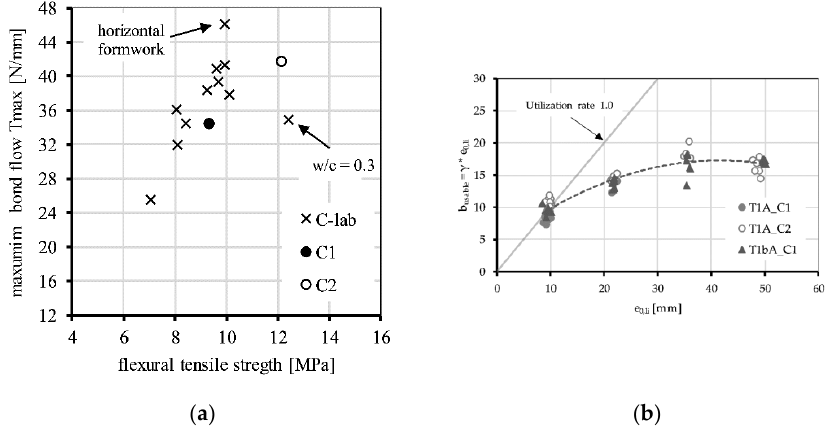
Figure 4. ( a ) The correlation between the flexural tensile strength of fine-grained concrete on the maximum bond flow; ( b ) the influence of the concrete width per fiber strand (e 0,li )/mesh width of the textile on the resistance against a splitting crack (T R,p ), calculated via a reduced concrete width (b usable ) [18]. (b usable )